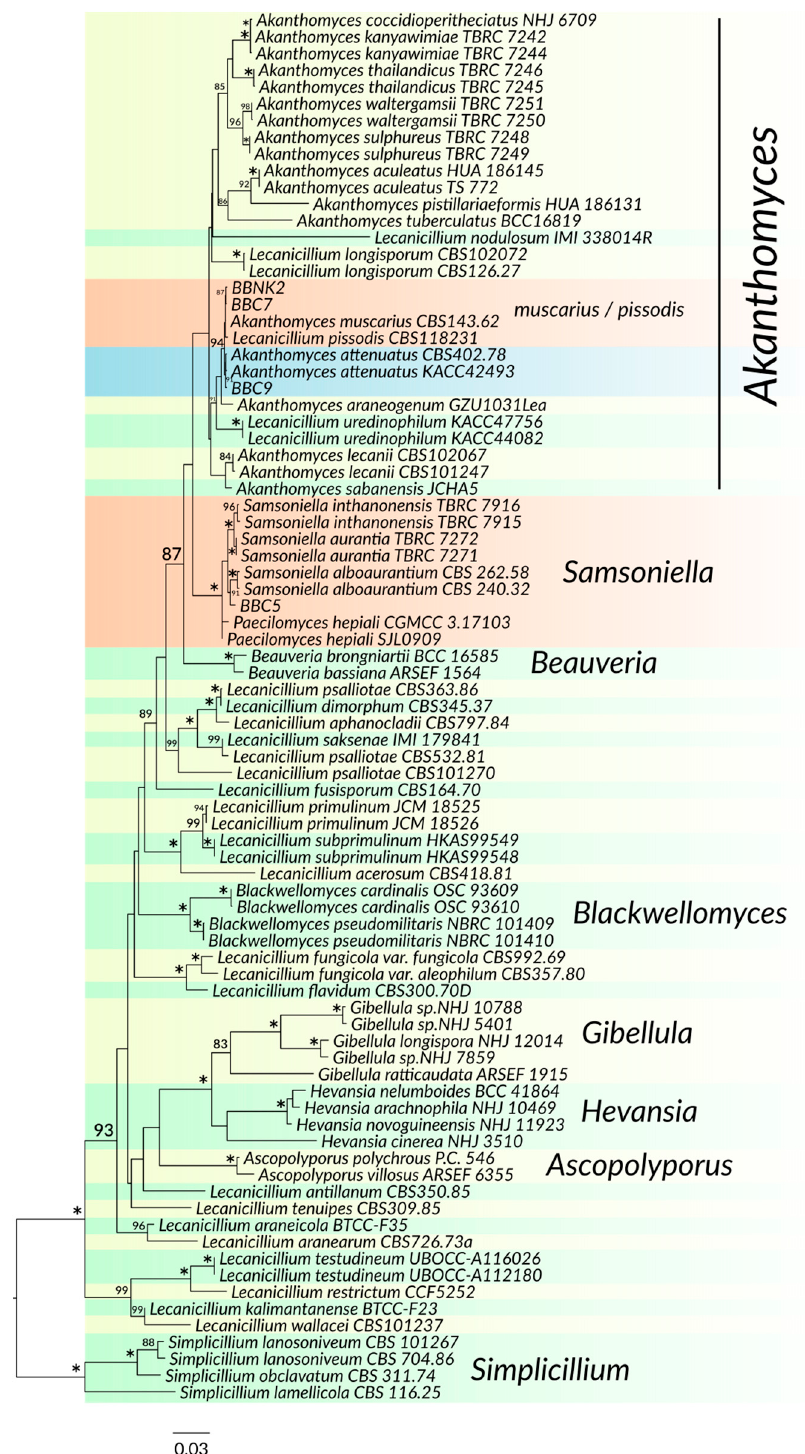
Figure 3. Maximum likelihood phylogenetic tree of the isolated strains BBC5, BBC7, BBC9 and BBCNK2 and related Cordycypitaceae species derived from a combined dataset of ITS + SSU + LSU + TEF + RPB1 + RPB2 sequences. Clades with newly isolated strains are highlighted in orange and blue. Only bootstraps over 80% are shown. A bootstrap of 100% is indicated with the asterisk.